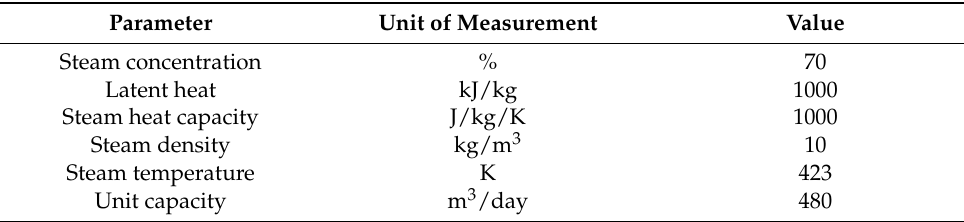
Table 2. Input data for numerical simulation by heat carrier parameters.